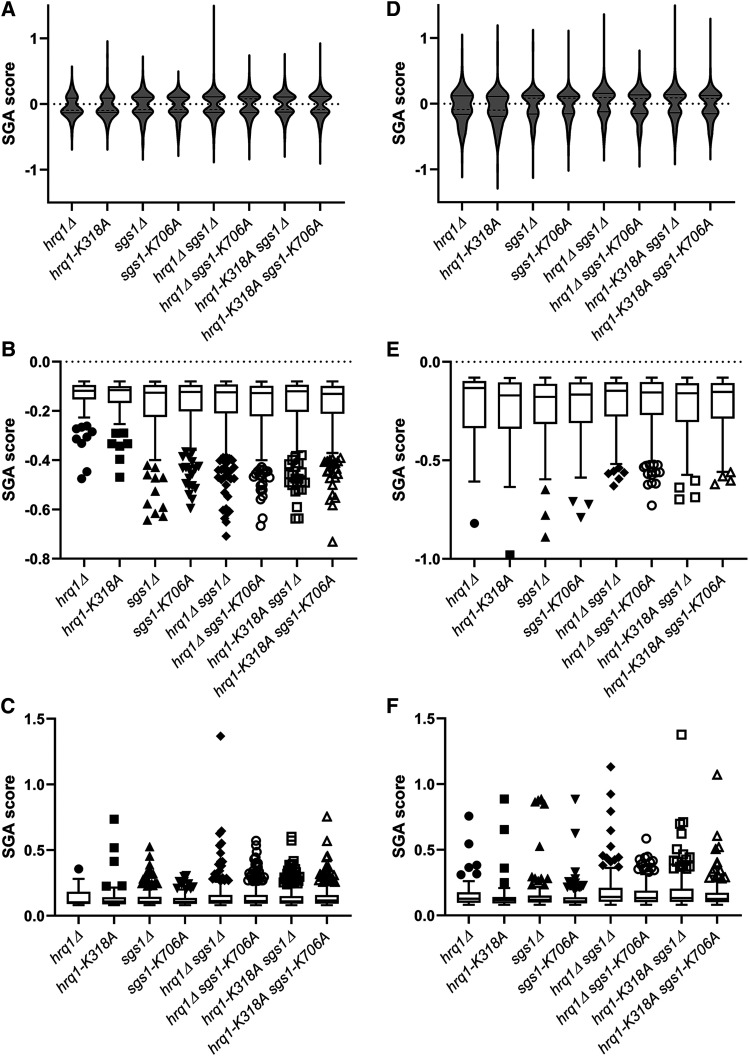
Analysis of the distribution of the magnitudes of the synthetic genetic interactions. Violin plots of the synthetic genetic interactions with the single-gene deletion collection (A) and TS collection (D). The median values are denoted with dashed lines, and the quartiles are shown as solid lines. The SGA data are also shown in separate box and whisker plots drawn using the Tukey method for the negative (B) and positive (C) interactions with the deletion collection, as well as for the negative (E) and positive (F) interactions with the TS collection. The individually plotted points outside of the inner fences represent outliers (i.e., interactions with mutants yielding the strongest SGA scores) and correspond to alleles whose SGA score is less than the value of the 25th quartile minus 1.5 times the inter-quartile distance (IQR) for negative interactions and alleles whose SGA score is greater than the value of the 75th quartile plus 1.5IQR for positive interactions. The significant differences between SGA data sets discussed in the main text were calculated using the Kruskal-Wallis test and Dunn’s multiple comparisons test.